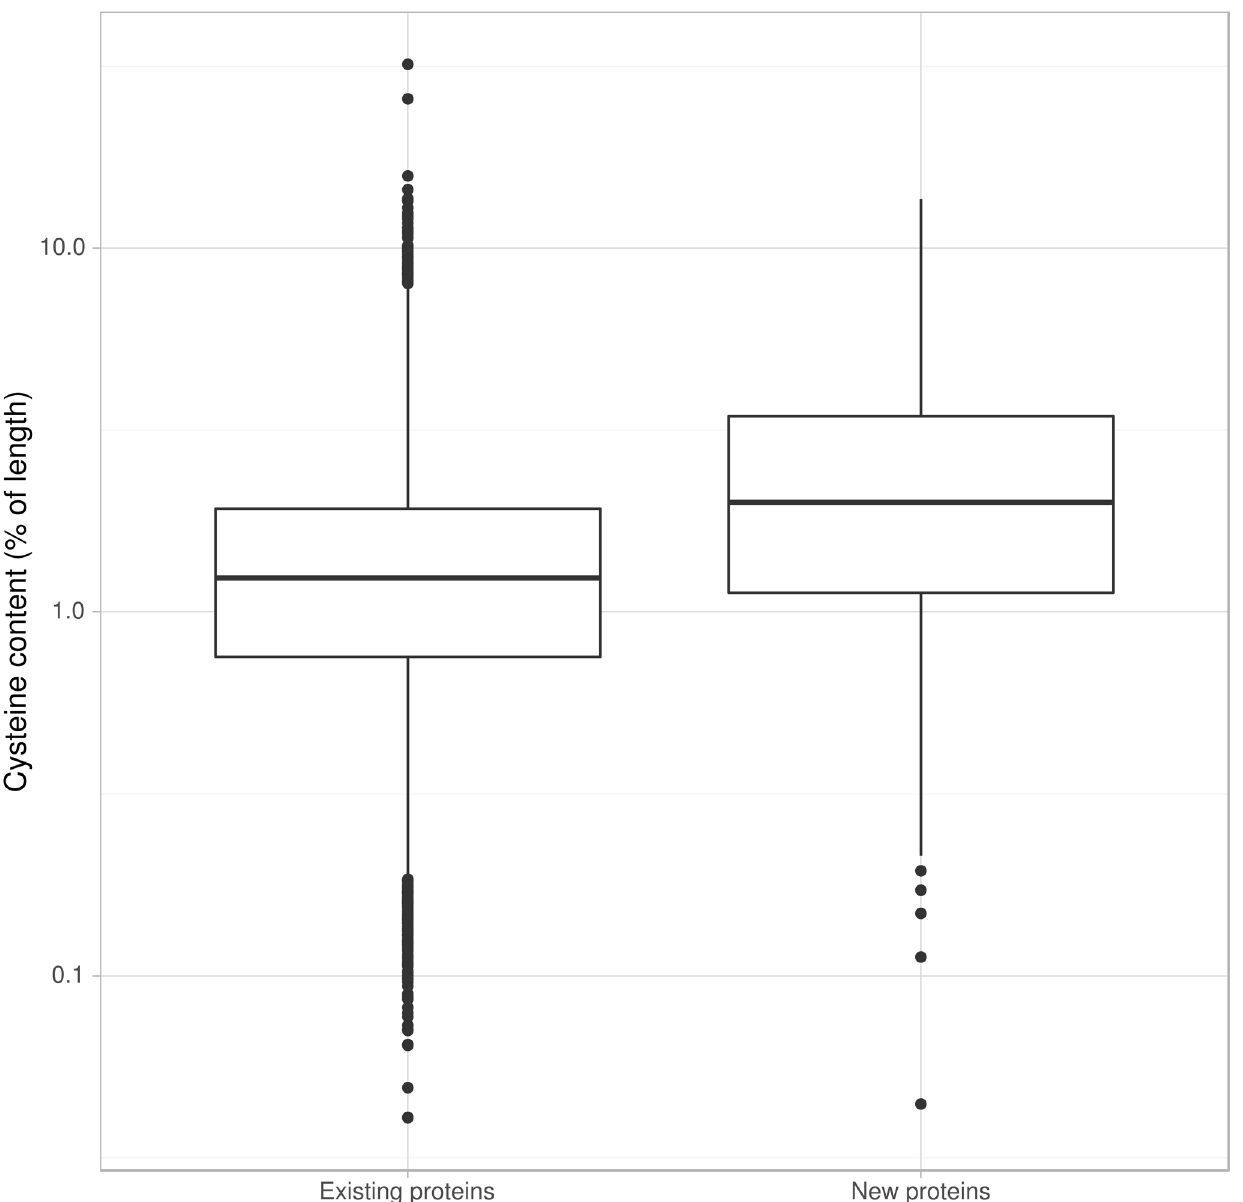
Fig 3. Proportion of cysteines in P . nodorum SN15 predicted proteins before and after gene re-annotation. New proteins are more likely to be cysteine-rich. Of the 54 cysteine-rich proteins in the new annotation set ( > 9% Cys by length), 16 are the products of newly annotated